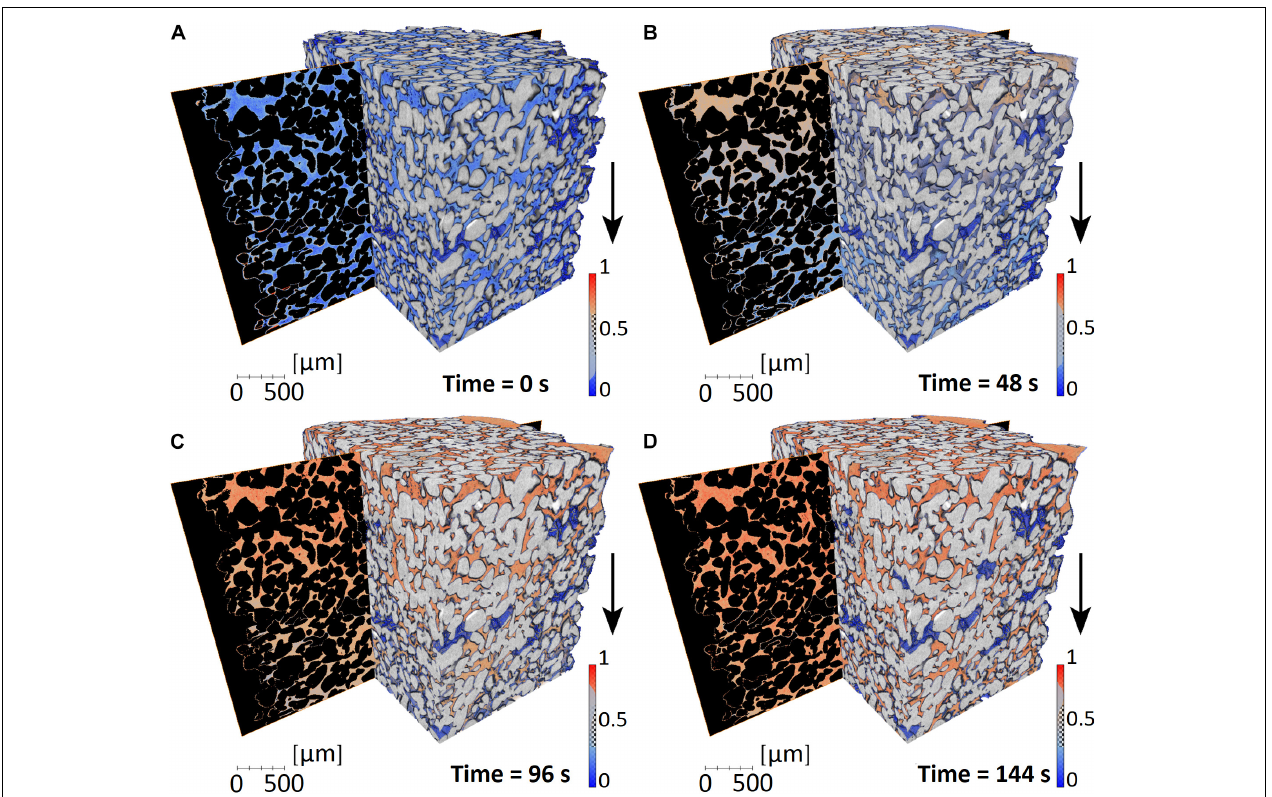
FIGURE 4 | Graphical rendering of the time series of tomographic datasets during the solute transport through a porous medium. Each panel refers to a distinct point in the time series. The time scale was set to 0 s for the dataset in panel (A) , corresponding to the time when the tracer starts to penetrate the porous medium. Each panel ( B for time = 48 s, C for time = 96 s, D for time = 144 s) shows the 3D rendering of two distinct and complementary sub-sets of the acquired X-ray phase contrast tomogram: the glass beads volume (in gray scale) and the liquid (in colors). Approximately one quarter of the porous medium volume is shown, while the rest was cut out in order to better show the liquid distribution inside the pore space. The arrows indicate the main flow direction. The color mapping is identical for all time points, and the liquid phase value range was renormalized to its maximum value in space and time during the overall experiment duration. The corresponding color bar is shown in each inset. More bluish colors correspond to smaller (normalized) solute concentration values while more reddish ones indicate higher concentrations. Additionally, a planar cross-section through the full extent of the liquid volume along the flow direction is shown in each panel. All voxels not belonging to the liquid phase are rendered in black in these vertical